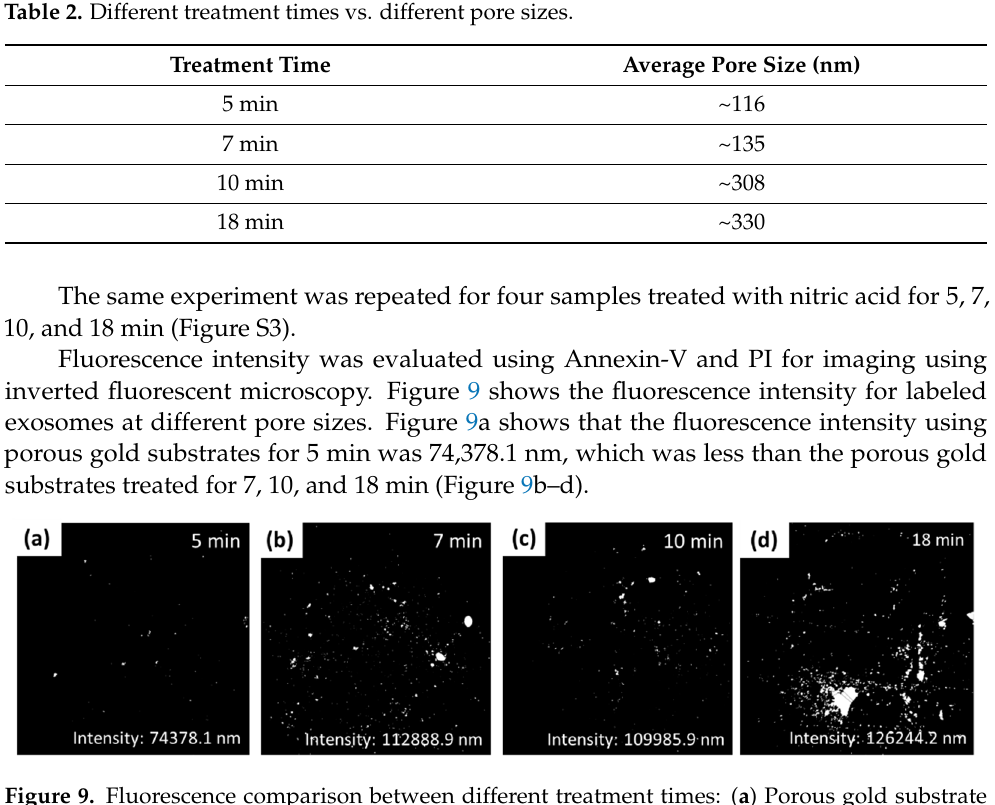
Figure 9. Fluorescence comparison between different treatment times: ( a ) Porous gold substrate treated for 5 min, average IntDen (Integrated Density) = 74,378.1 nm; ( b ) Porous gold substrate treated for 7 min, average IntDen (Integrated Density) = 112,888.9 nm; ( c ) Porous gold substrate treated for 10 min, average IntDen (Integrated Density) = 109,985.9 nm; ( d ) Porous gold substrate treated for 18 min, average IntDen (Integrated Density) = 126,244.2 nm.